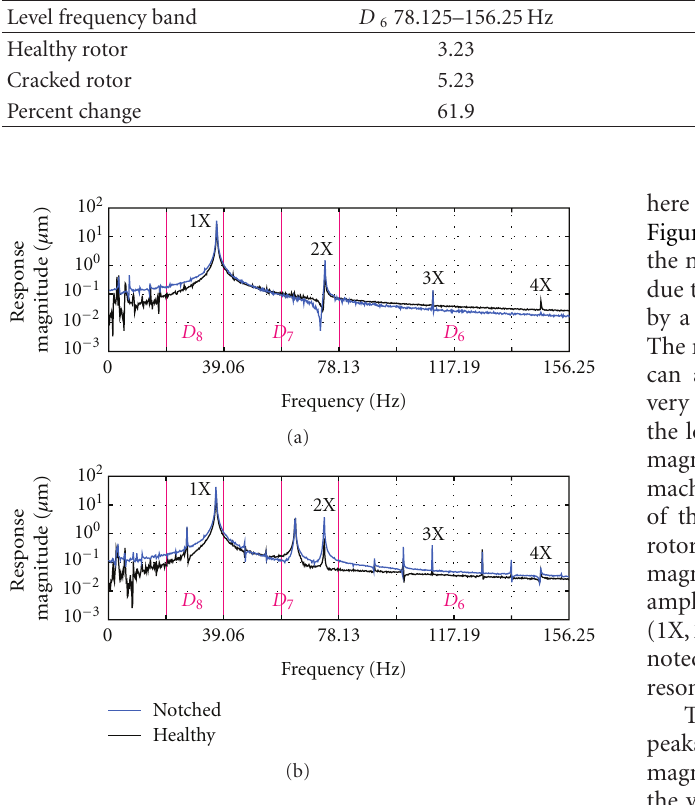
Figure 8: Measured response magnitude of rotor vibrations versus frequency for healthy and notched rotors, without (a) and with (b) external excitation. Rotational frequency is 36.7 Hz, magnetic actuator frequency is 63 Hz, and frequency bands D 6 (78.125– 156.25 Hz), and D 7 (39.06–78.125 Hz), and D 8 (19.53–39.06